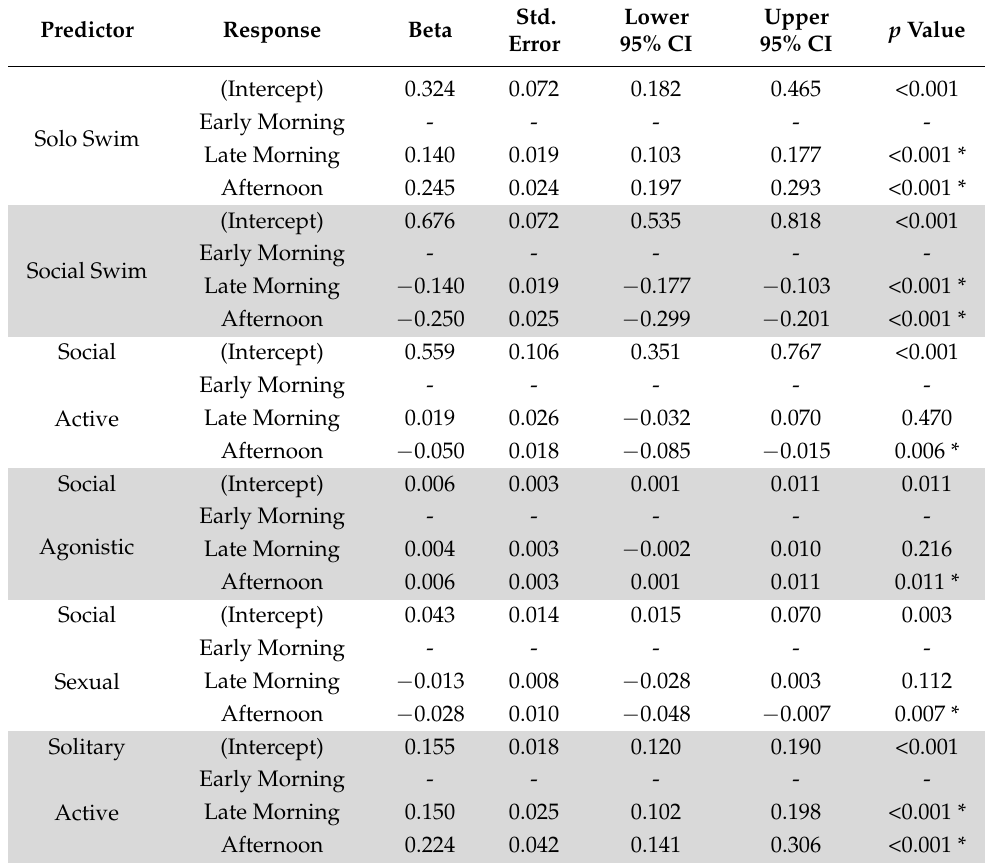
Table 4. Results for models examining behavior and swim type categories.